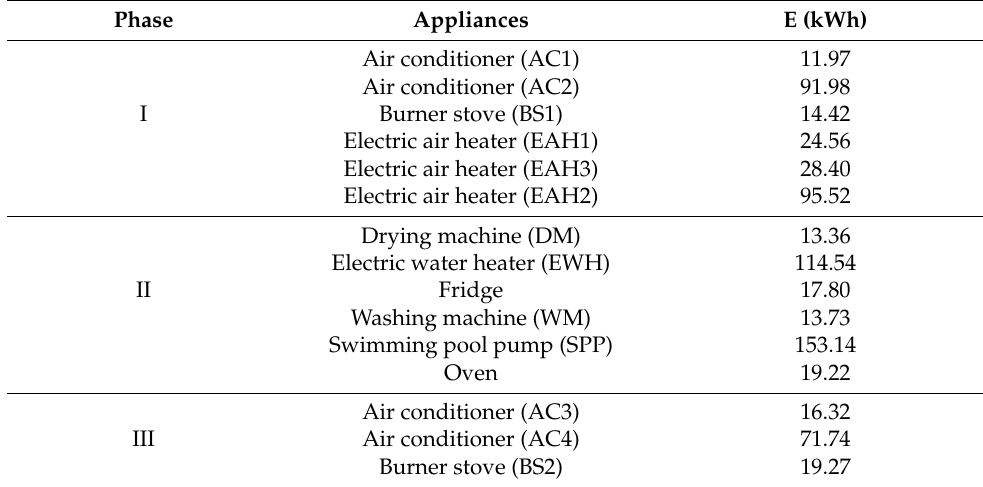
Table 25. Distribution of energy consumption in the case study house.